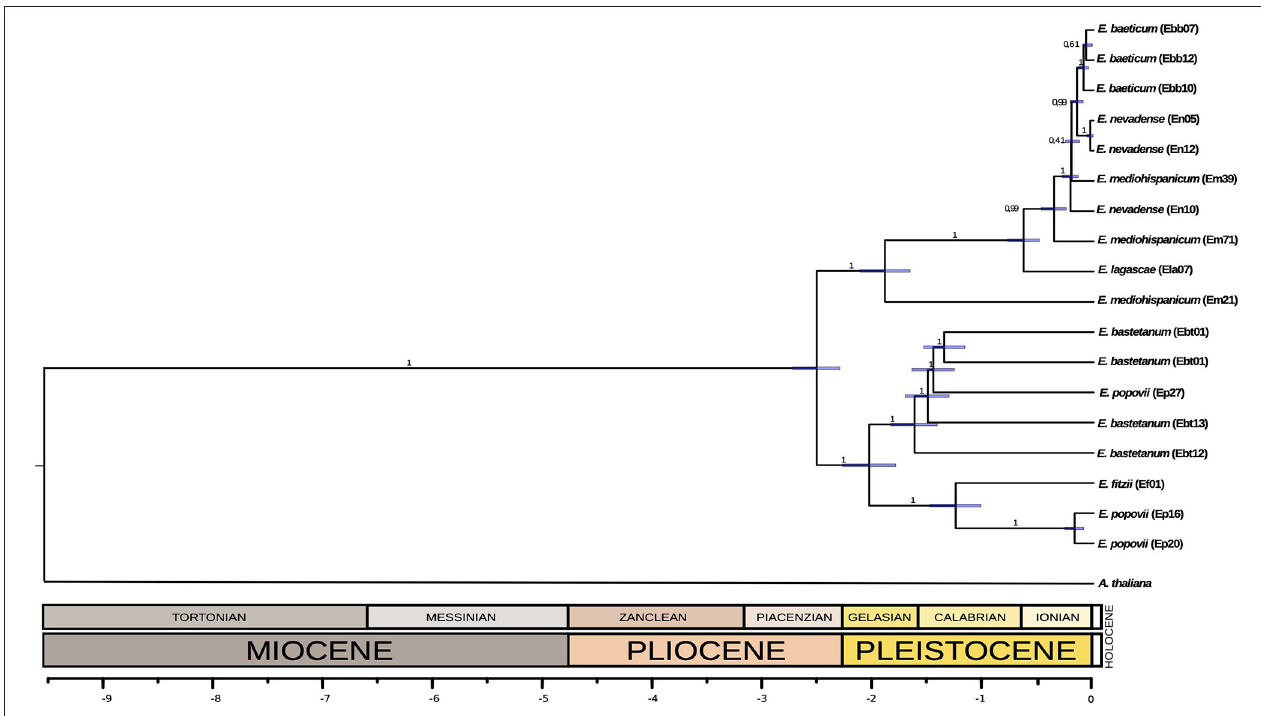
FIGURE 2 | A time-calibrated phylogeny for the chloroplast DNA of the different populations of the Erysimum species analyzed here. Note the reticulated position of some populations, probably due to hybridization events.